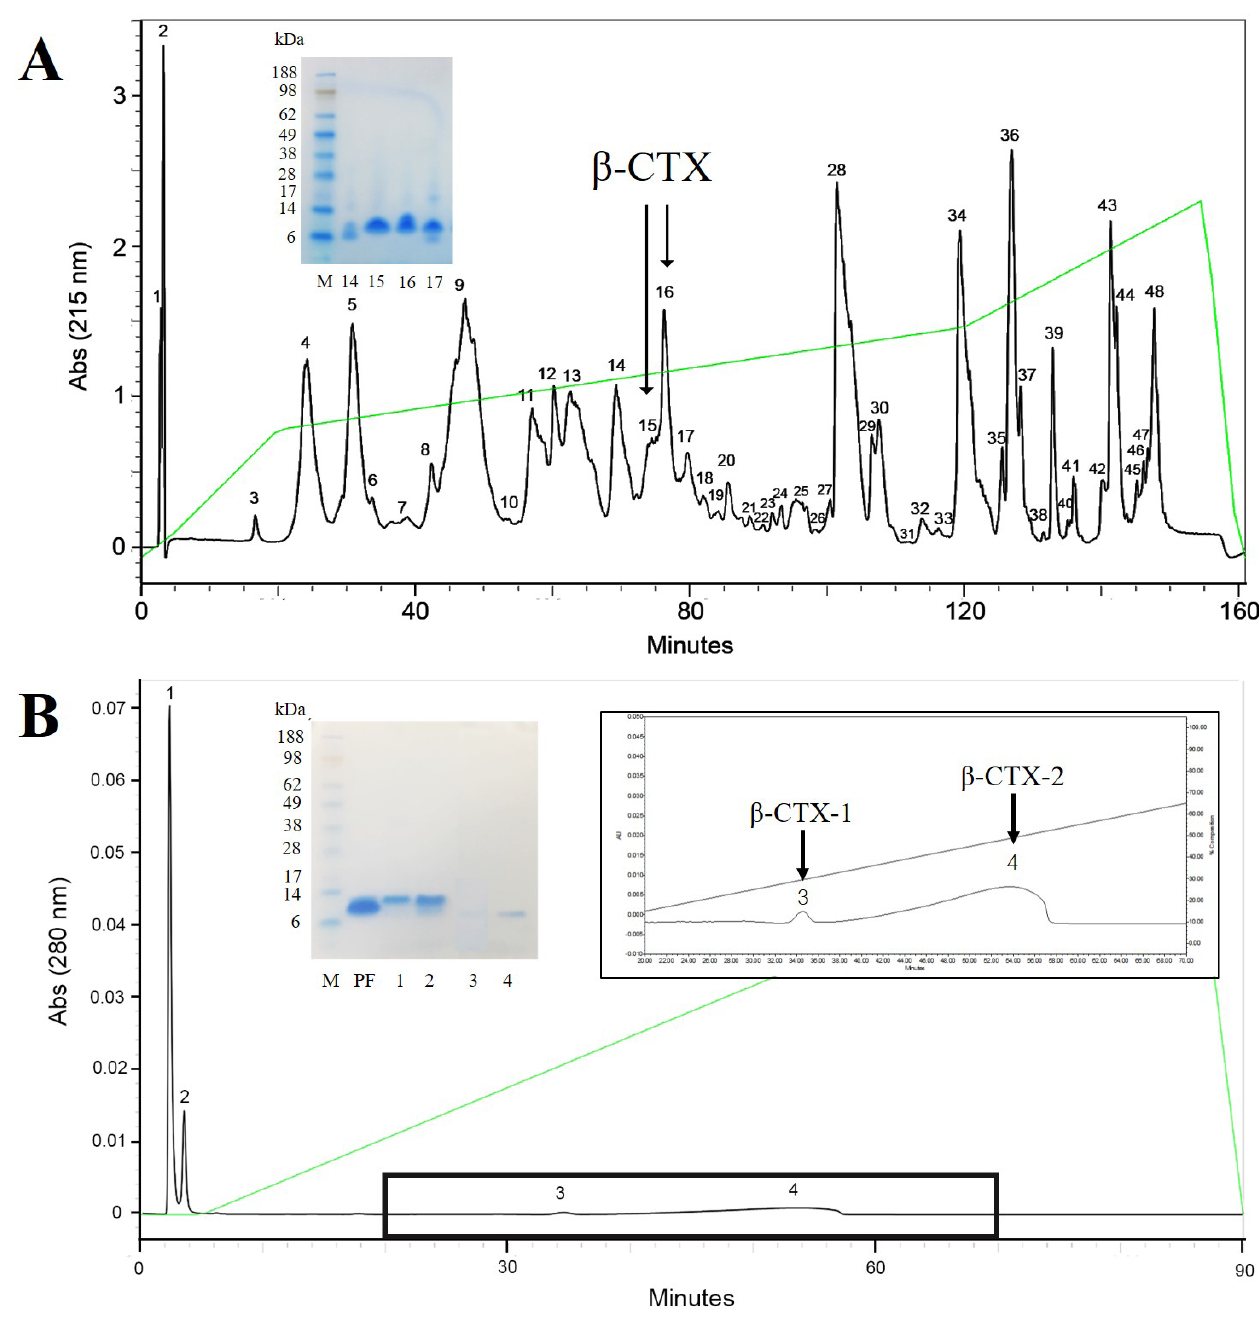
Figure 1. Chromatographic profiles of the β-CTX purification. (A) Reverse phase chromatographic profile represents fractions containing β-CTX (arrows), identified by SDS-PAGE (inset) and automated N-terminal sequencer. (B) Cation exchange HPLC profile of the pooled fractions (PF) 15-16th from the reverse phase HPLC. (Inset) β-CTX-1 and -2 were identified in both subfraction 3 and 4, respectively (arrows). All fractions were determined the protein constituents by running SDS-PAGE (inset) and N-terminal sequencer. M = protein marker (SeeBlue TM Plus2, Thermo Fisher ®